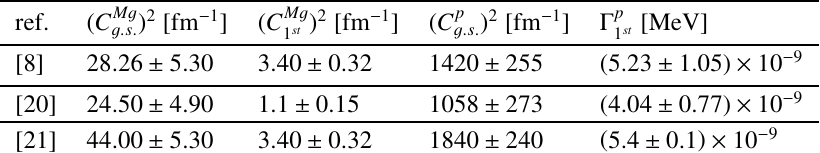
Table 1. Values found in [8] and compared with [20] and [21]